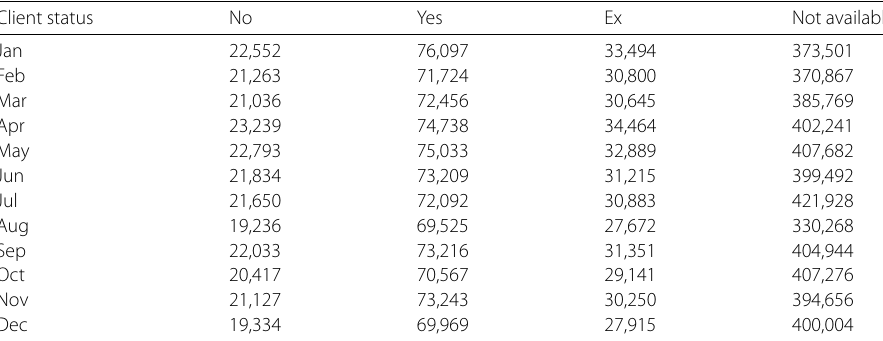
Table 6 Number of payer-only by customer status Client status No Yes Ex Not available